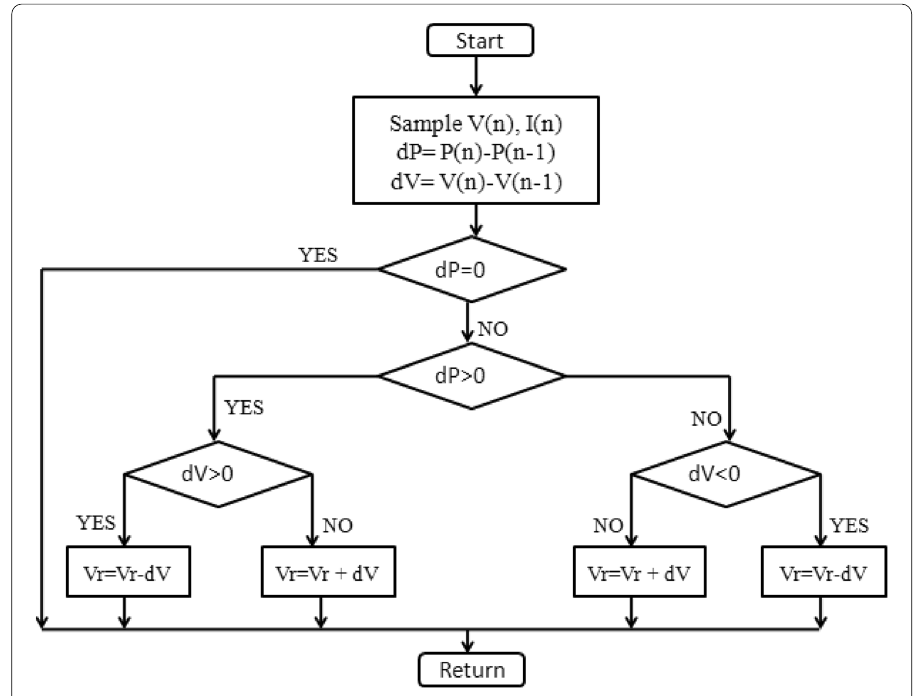
Fig. 4 Flowchart of MPPT